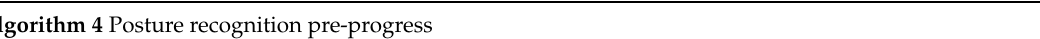
Algorithm 4 Posture recognition pre-progress